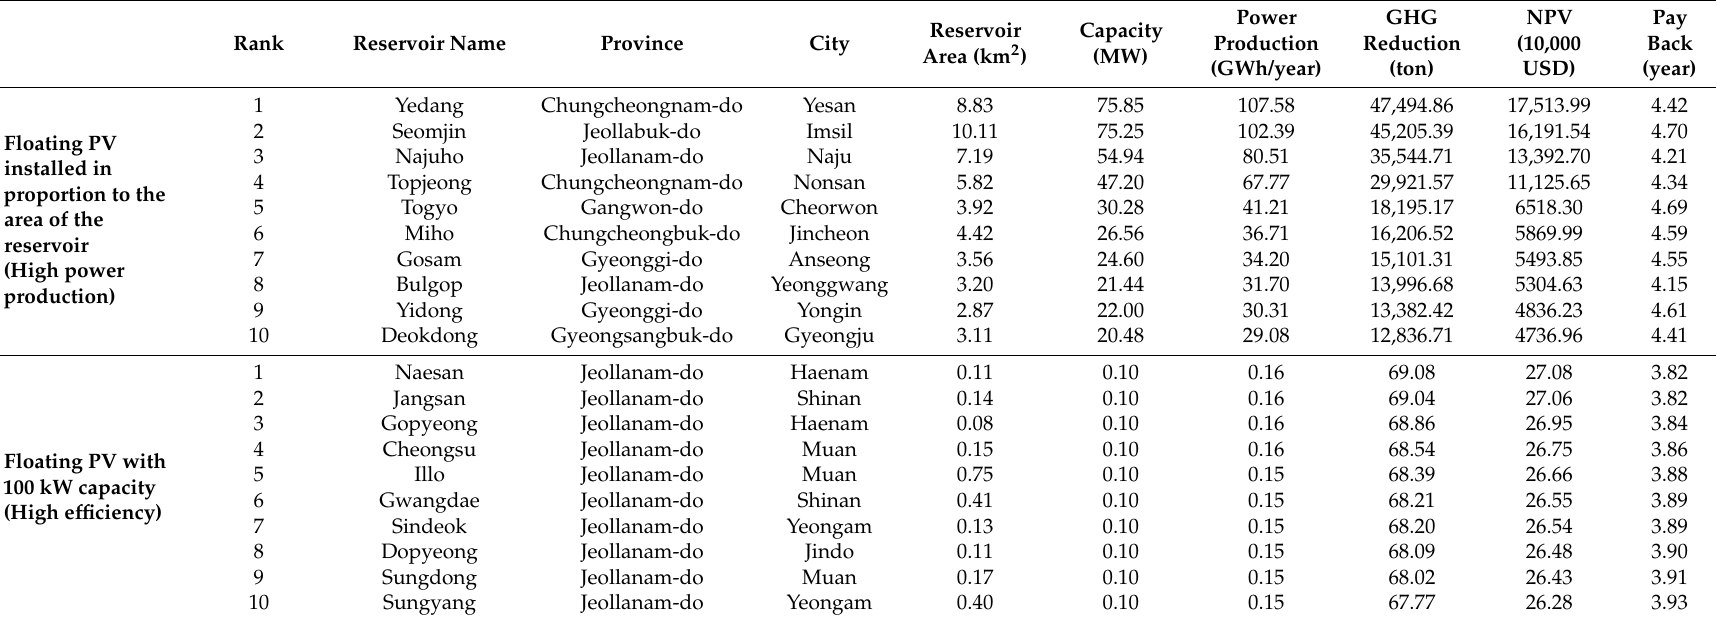
Table 4. The analysis results of the top 10 reservoirs with the highest power production and with the highest